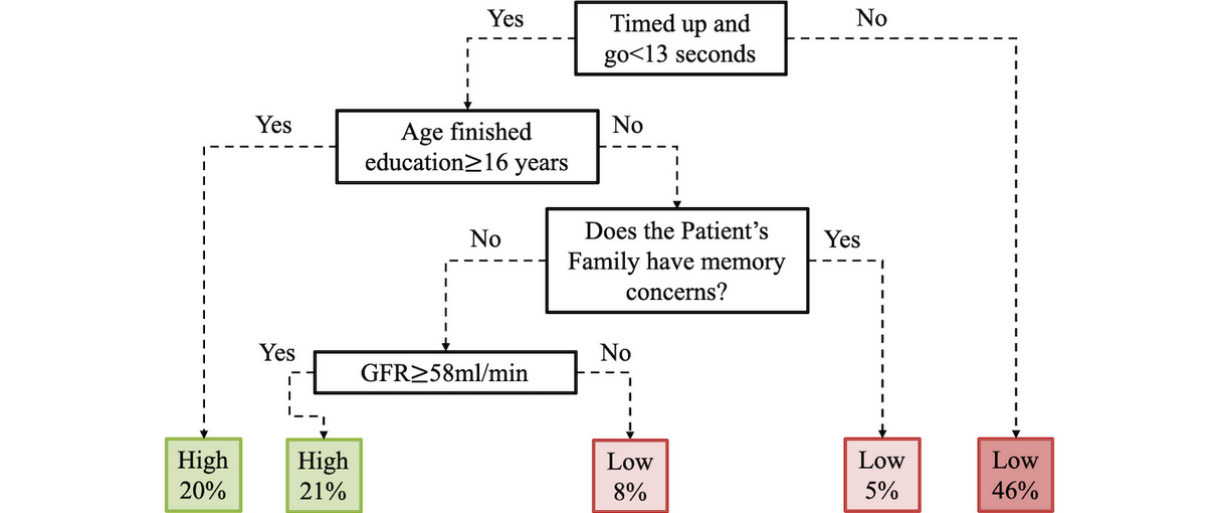
Figure 9. Decision tree classifier of the Repeatable Battery for the Assessment of Neuropsychological Status score. GFR: glomerular filtration rate.